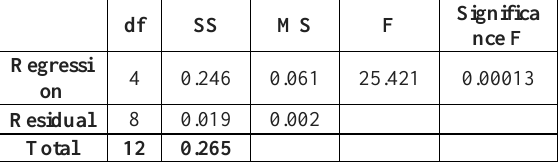
Table 3: ANOVA test